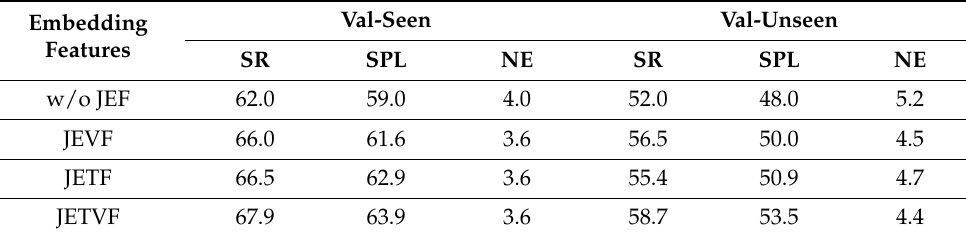
Figure 7. Different embedding features: ( a ) without joint embedding features (w/o JEF), ( b ) joint embedding visual features (JEVF), ( c ) joint embedding textual features (JETF), and ( d ) joint embedding textual and visual features (JETVF). Table 1. Comparison among different embedding features (SR: success rate, SPL: success rate weighted by path lengths, NE: navigation error, JEF: joint embedding features, JEVF: joint embedding visual features, JETF: joint embedding textual features, and JETVF: joint embedding textual and visual